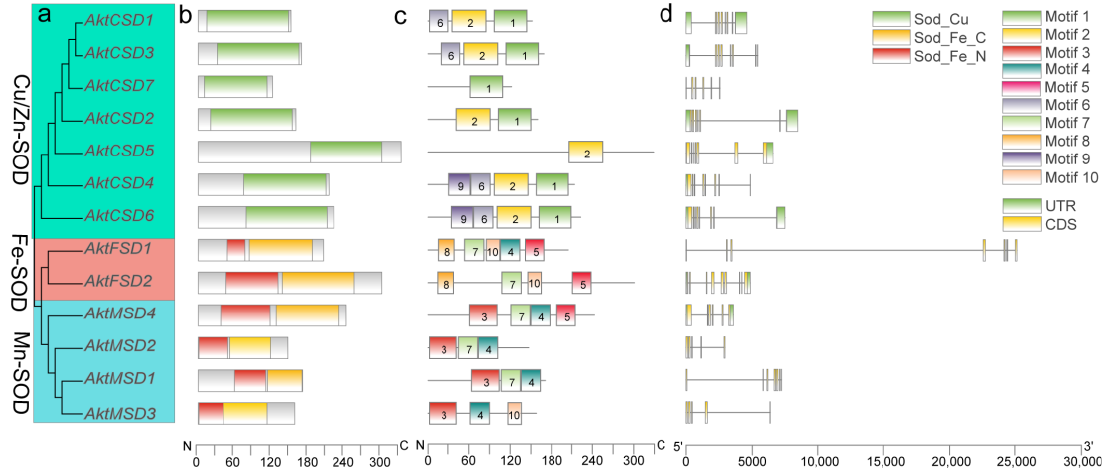
Figure 2. Gene and protein structure analyses of AktSOD families. ( a ) Phylogenetic tree of AktSOD genes. ( b ) Conserved domains of AktSOD proteins. ( c ) Motifs of AktSOD proteins. ( d ) Exon–intron structures of AktSOD genes.